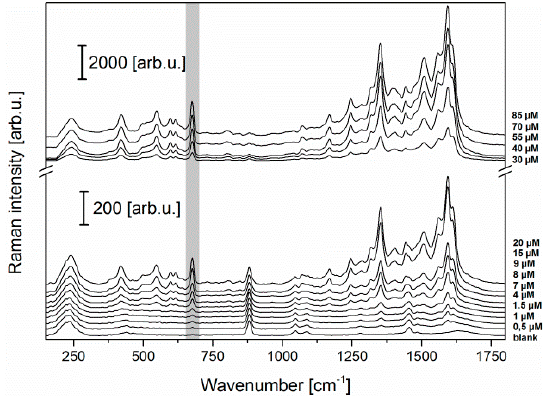
Figure 2. Mean SERS spectra of PYO with concentrations between 0.5 and 85 μ M in aqueous solution measured in the microfluidic platform. The mean spectrum of the blank (when only water–ethanol solution is pumped through at the first dosing unit) is also presented.